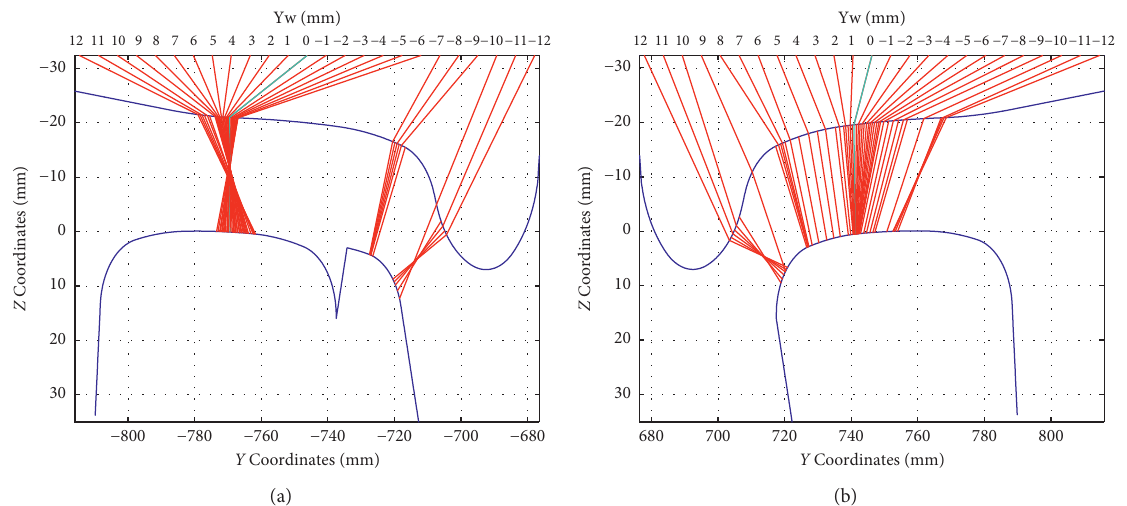
Figure 16: Distribution of wheel-rail contact points before optimization: (a) switch rail and (b) stock rail.